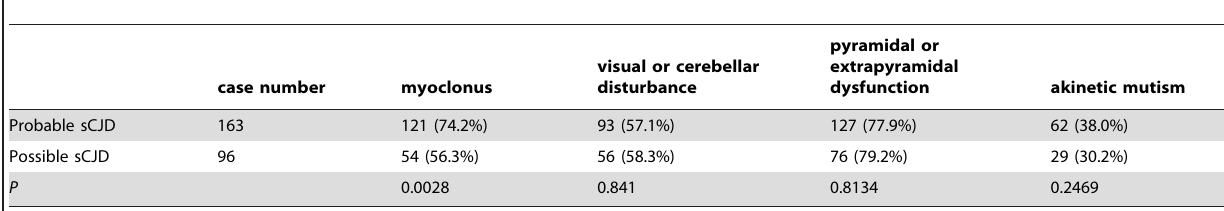
Table 2. The appearances of main clinical manifestations except progressive dementia in probable and possible sCJD